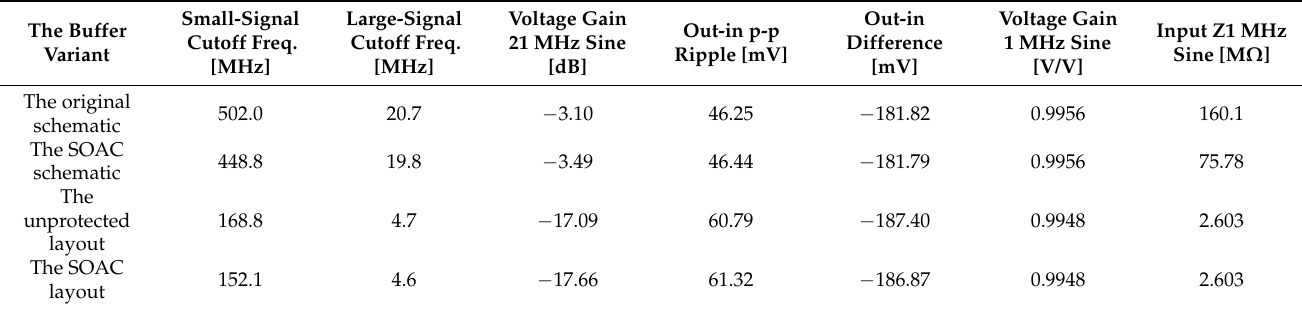
Table 4. Comparison of the buffer properties for all the selected implementation